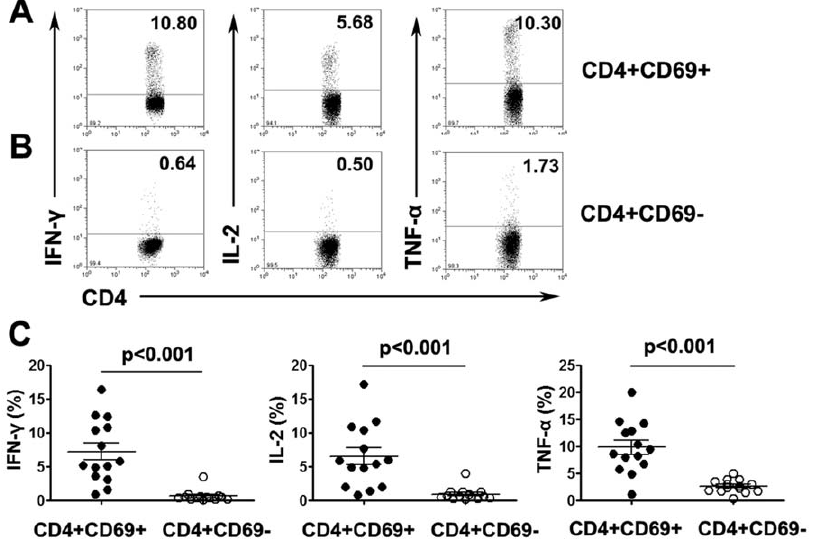
Figure 3. Th1 cytokine-producing cells were enriched within CD4 + CD69 + T cells. (A, B) PFCs were stimulated with ESAT-6/CFP-10 peptides (P1-P6), anti-CD28mAbs, anti-CD49d mAbs and BFA for eight hours. Cells were gated on CD4 + CD69 + and CD4 + CD69 2 T cell populations. Representative expression of IFN- c , IL-2 and TNF- a on CD4 + CD69 + (A) and CD4 + CD69 2 T cells (B) is shown. The numbers in each quadrant represent the percentages of positive cells in gated T cells. (C) Summary data of the frequency of cytokine-producing CD4 + CD69 + and CD4 + CD69 2 T cells (n=14). Horizontal lines represent means 6 SD.